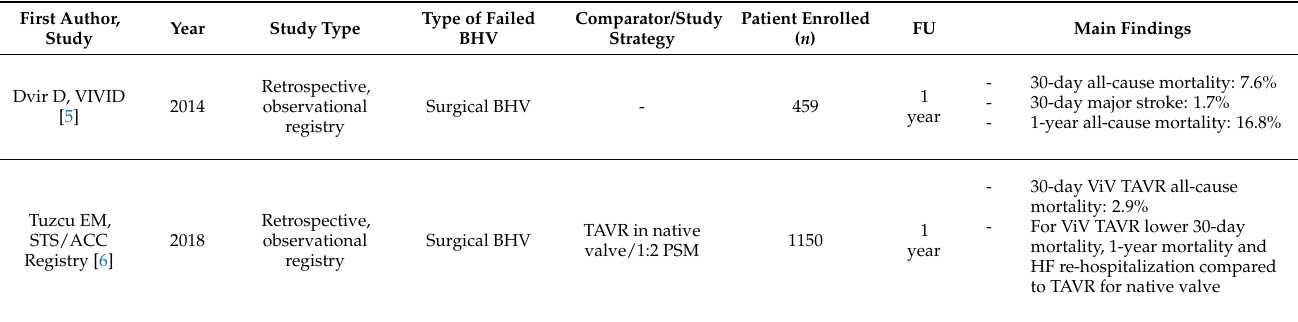
Table 1. Available evidence concerning ViV TAVR safety and